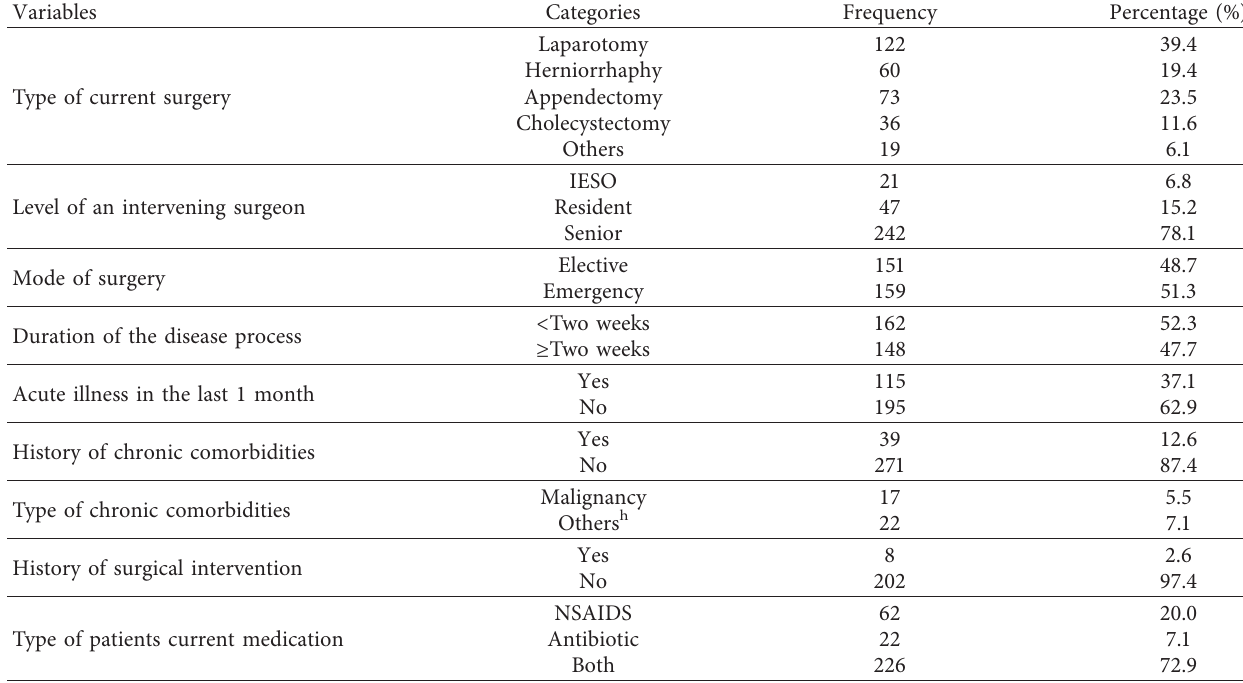
Table 3: Clinical features of adult patients who had undergone abdominal surgery at Bahir Dar City Public Hospitals, Northwest Ethiopia, 2019 ( N �